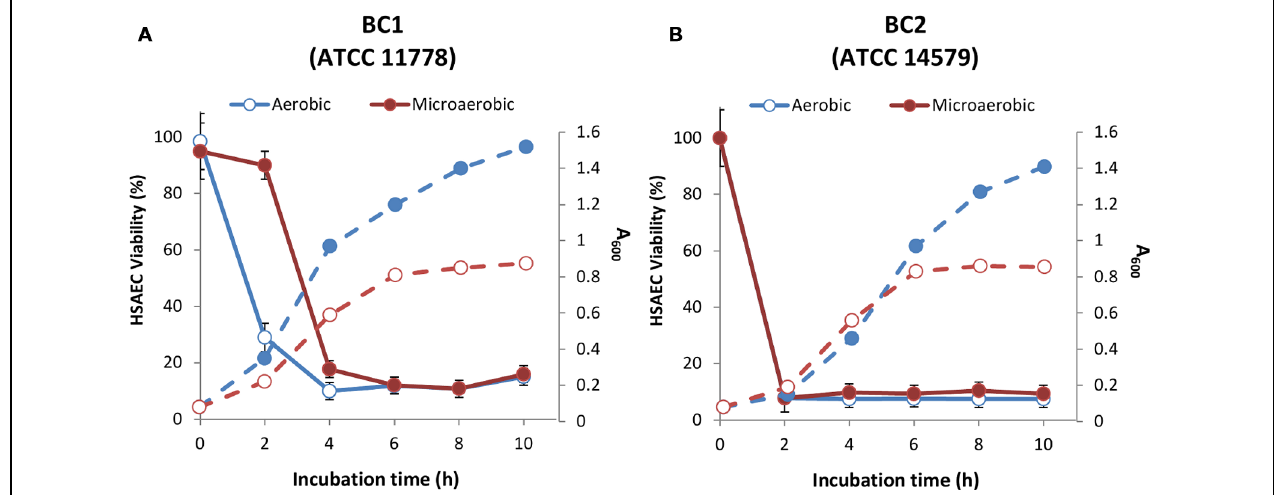
FIGURE 1 | The growth (dashed lines) and toxicity (solid lines) of BC1 (A) and BC2 (B) under microaerobic and aerobic conditions (filled and open circles, correspondingly). Overnight cultures were grown in aerated LB medium and used to inoculate CSFM (1:100). For static microaerobic cultures the inoculated medium was dispensed into 24-well plate (2 mL per well) and incubated at 37 ◦ C and 5% CO 2 without shaking. For aerobic cultures, 20 mL of inoculated CSFM in a 50 mL Falcon tube were shaken at 200 rpm and 37 ◦ C. The cultures were harvested every hour post-inoculation and their OD measured at 600 nm. Bacteria were pelleted and the Sups were used to expose HSAECs for 2 h at 37 ◦ C. Cell viability was assessed relative to untreated HSAECs using resazurin as described in the Section “Materials and